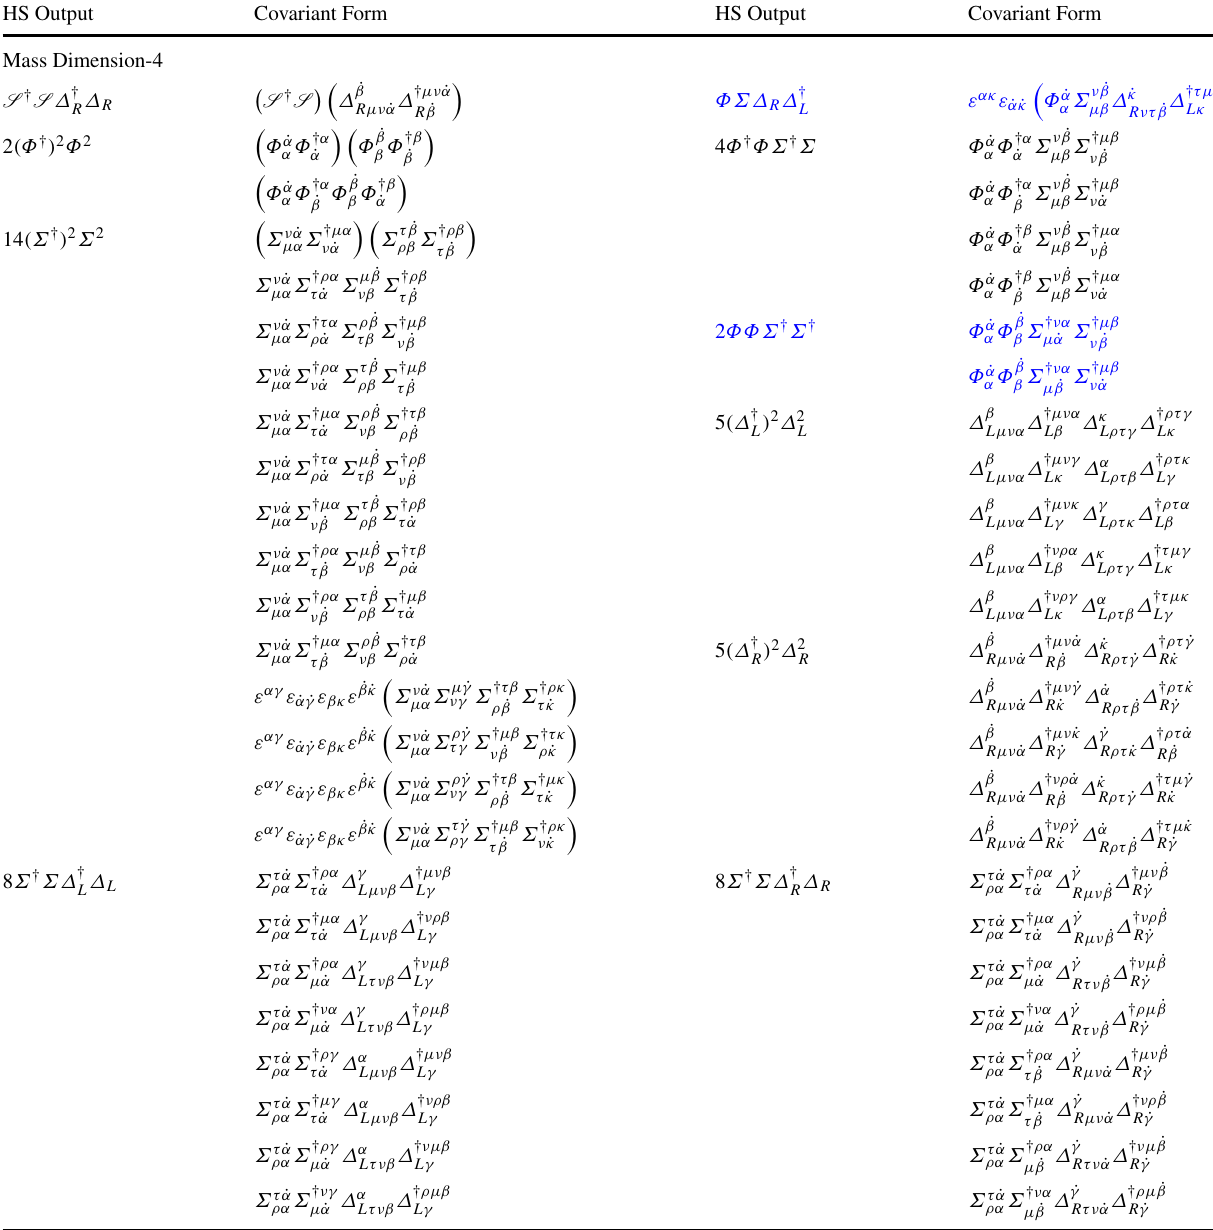
Table 8 Table 7 continued. The operator structures highlighted in red show discrepancies when compared with the results of [68] HS Output